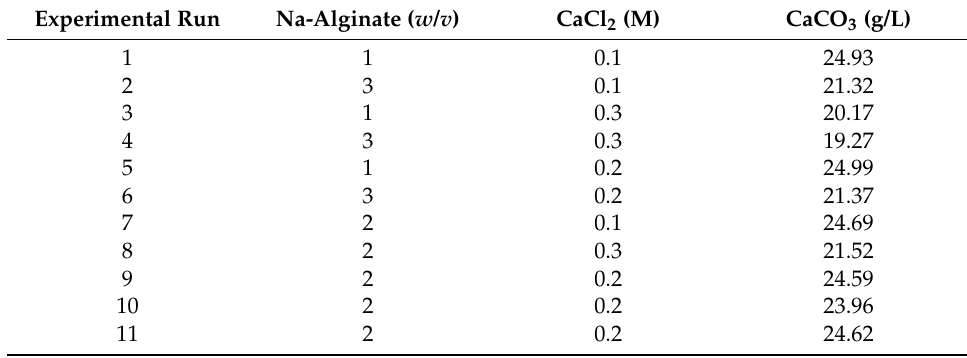
Table 1. Level of variables examined in optimization using central composite face (CCF) design. Experimental Run Na-Alginate ( w / v ) CaCl 2